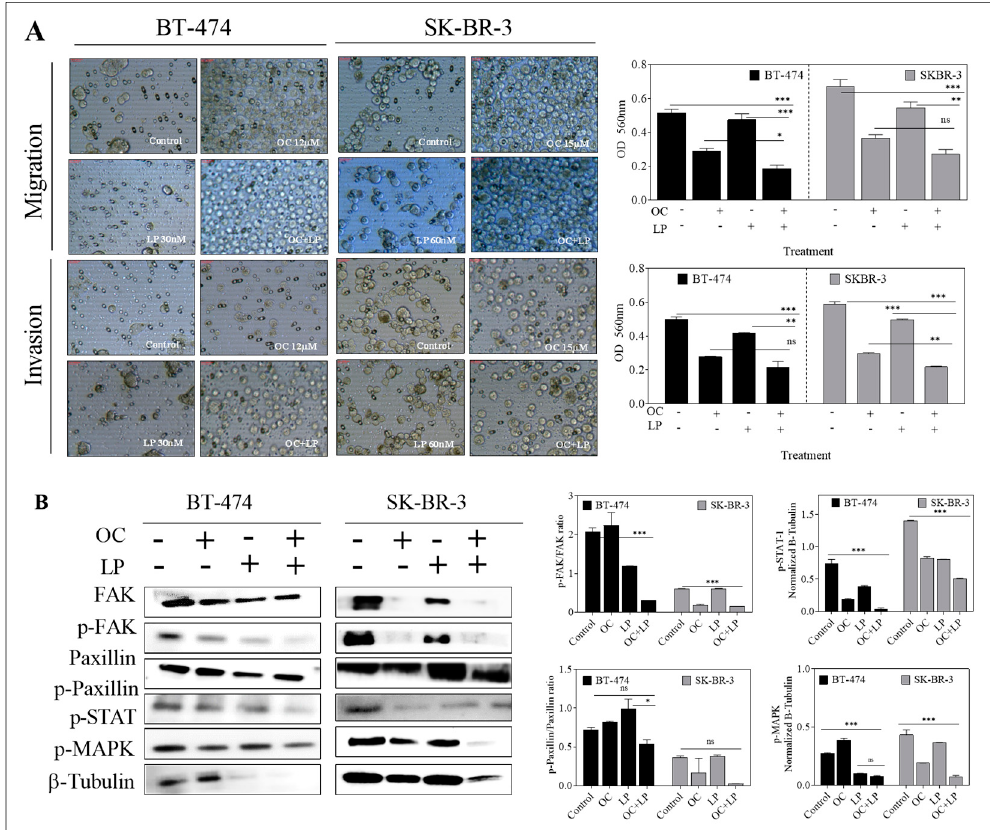
Figure 5. Effect of combined OC and LP treatment on migration and invasion of HER2-positive BC cells and downstream signaling effectors. ( A ) Effect of OC and LP treatment on migration and invasion of BT-474 and SK-BR-3 BC cells. Optical density in migration and invasion assay in BT-474 and SK-BR-3 cells. Cells were seeded according to the manufacturer protocol and as described in “Methods”. In both assays, the provided images were taken for the upper surface of the inserts ( B ) Western blot analysis for the effect of combined OC and LP treatment on total and active levels of proteins controlling cell migration and invasion. Whole cell lysates were prepared for separation by polyacrylamide gel electrophoresis followed by Western blot analysis. Imaging and analysis were performed as mentioned earlier. * p < 0.05, *** p < 0.001 as compared with either individual OC or LP treatment or vehicle treatment. ns, not statistically